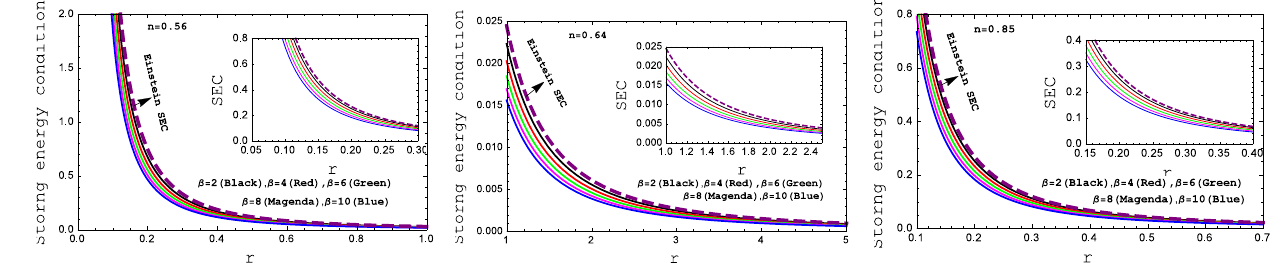
Figure 6. Behavior of the “Strong energy condition” with respect to the radial coordinate “r” for the compact stars PSR J1614-2230 ( left panel ), Vela X-1 ( middle panel ) and 4U 1538-52 ( right panel ) corresponding to the numerical value of constants A and B from Table 2 and for different values of β .